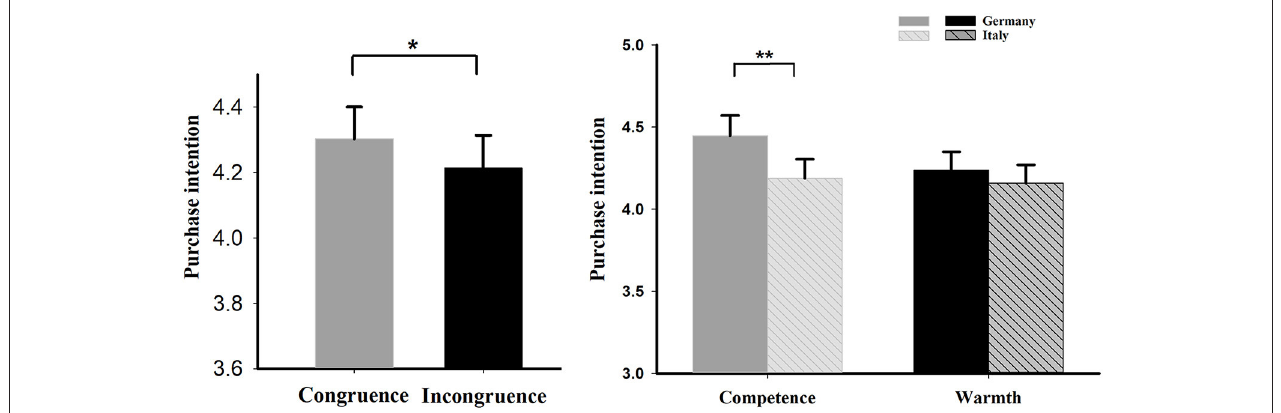
FIGURE 2 | Purchase intention results. * p < 0.05, ** p <